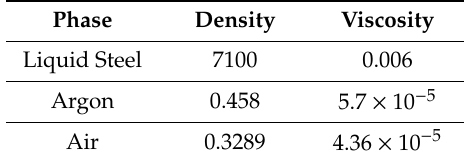
Table 1. Physical properties of the phase in the tapping operations.